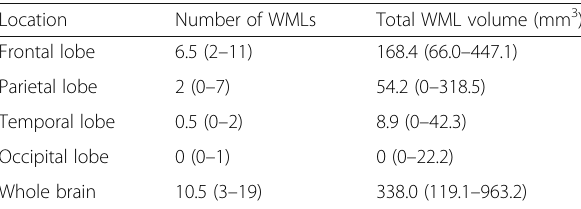
Table 5 Location, number and size of WMLs in the migraine group with